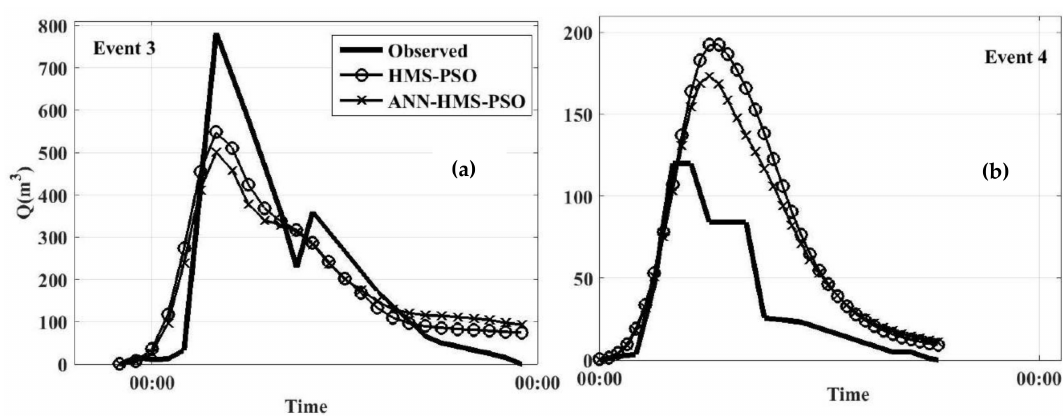
Figure 7. Observed and simulated discharge hydrographs for jointly JEvent 1,2 occurred on ( a ) 19 September 2004; and ( b ) 6 May 2005 respectively.